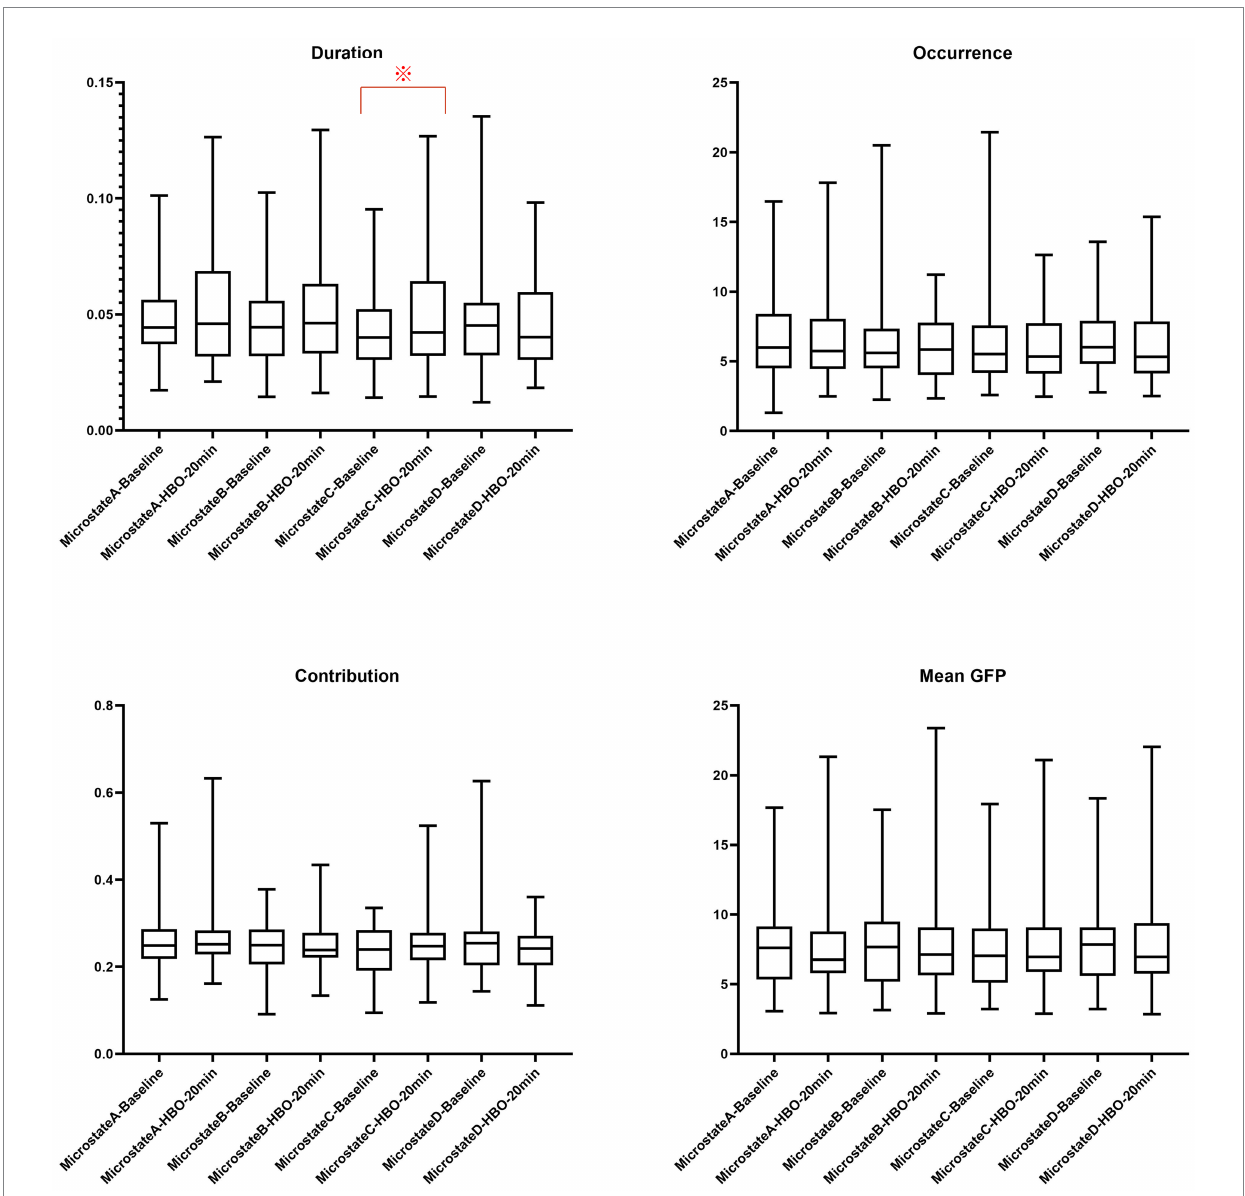
FIGURE 2 EEG microstate duration, occurrence, contribution and mean GFP analysis results of all DOC patients (41 cases). ※ Indicates the t -test result was significant ( p <